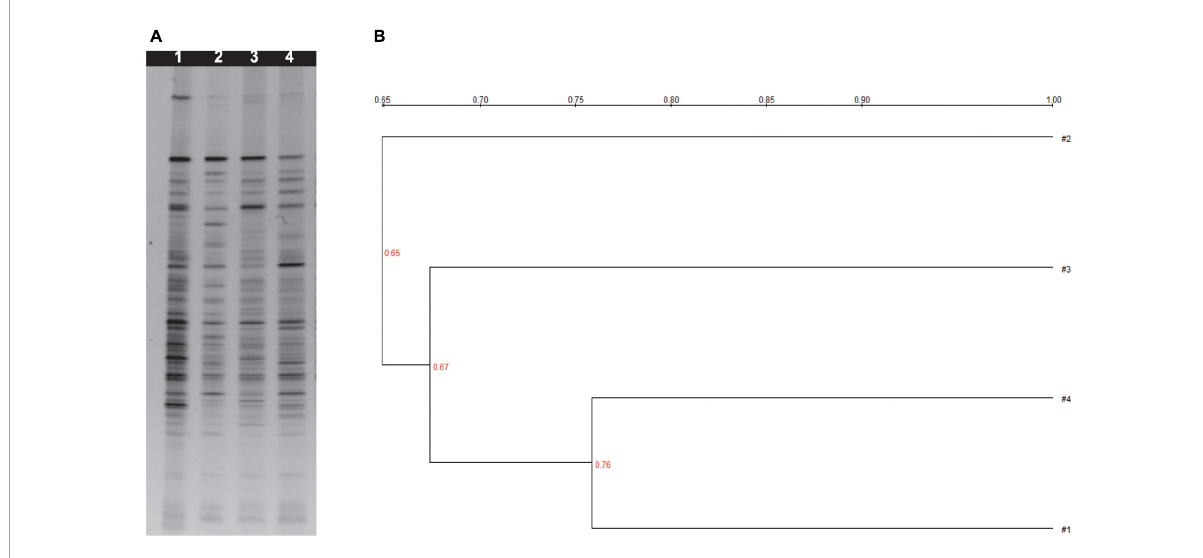
FIGURE3 (A) Denaturing gradient gel electrophoresis profiles from bacteria of fresh mice feces. (B) Cluster analysis analyzing Dice similarity index of DGGE profiles. 1 was treated with control; 2 was treated with 12 g/kg millet porridge; 3 was treated with 6 g/kg millet porridge; and 4 was treated with 3 g/kg millet